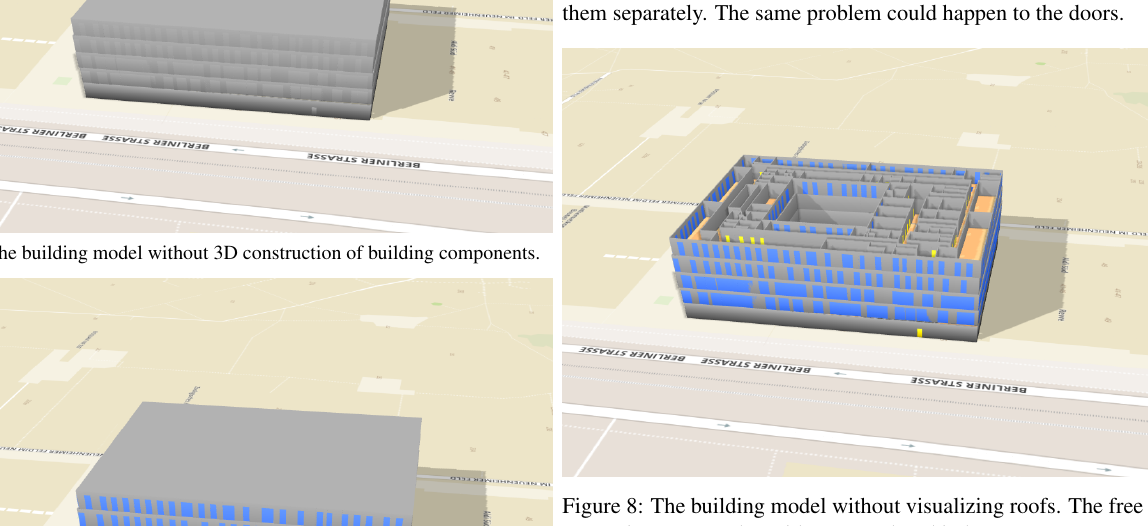
Figure 8: The building model without visualizing roofs. The free spaces in rooms and corridors are colored in brown.